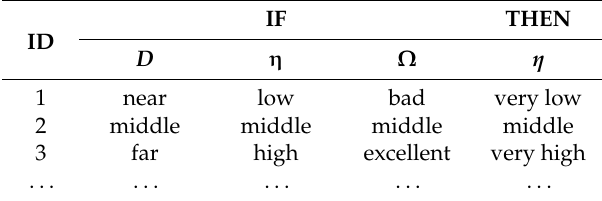
Table 5. Part of fuzzy reasoning rule